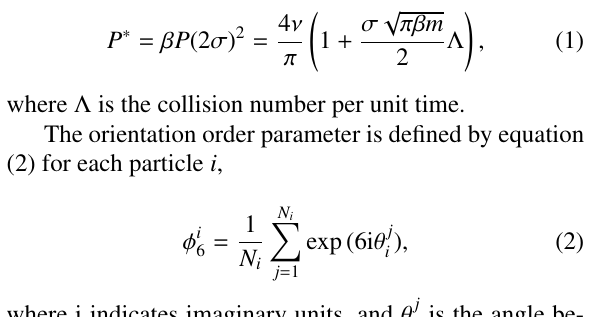
Figure 1. The relaxation time for various physical properties and the local density variance in terms of initial packing fraction are , Φ L , P ∗ , and N shown. Φ G D are global, local order parameter, 6 6 dimensionless pressure, and the number of disks where N i , 6, respectively. The non-trivial slow decay around ν = 0 . 708 can be